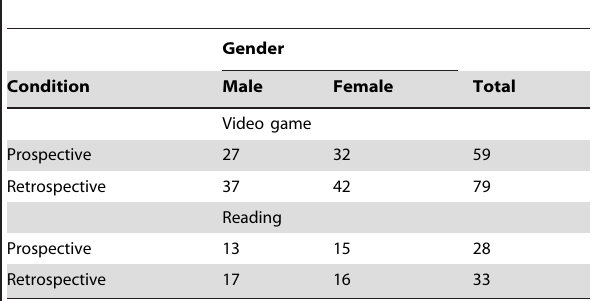
Table 1. Number of males and females in each condition.